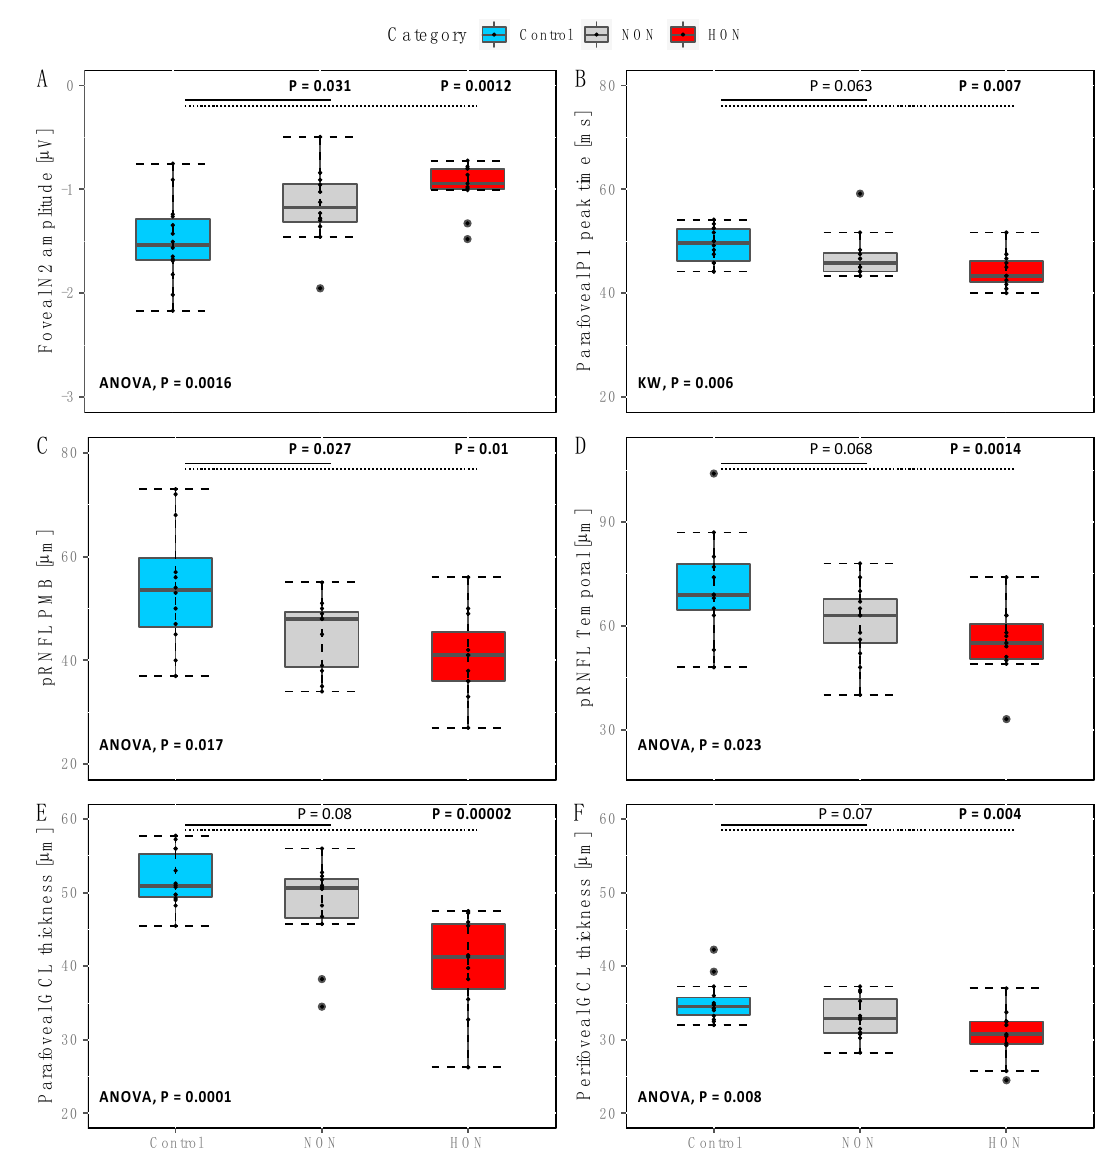
Figure 2. Post hoc analysis of ERG and OCT parameters. ( A ) Comparison of foveal (ring 1) N2 amplitude between groups with P values comparisons between MS without optic neuritis (NON) vs. controls (solid line) and MS with a history of optic neuritis (HON) vs. controls (dotted line). ( B ) Parafoveal P2 peak time (ring 2) significantly different between controls and HON. ( C ) Peripapillary retinal nerve fiber layer thickness at the papillomacular bundle (pRNFL PMB) also with significant differences between either patient groups vs. controls. ( D ) pRNFL of the temporal sector with only significant difference between HON and controls. ( E , F ) Parafoveal and perifoveal ganglion cell layer (GCL) with significant difference between HON and controls. Boxplots: lower whisker = smallest observation ≥ lower hinge—1.5 * Interquartile range (IQR); lower hinge: 25% quantile; median; upper hinge: 75% quantile; upper whisker = largest observation ≤ to upper hinge + 1.5 * IQR. Significant differences highlighted in bold.